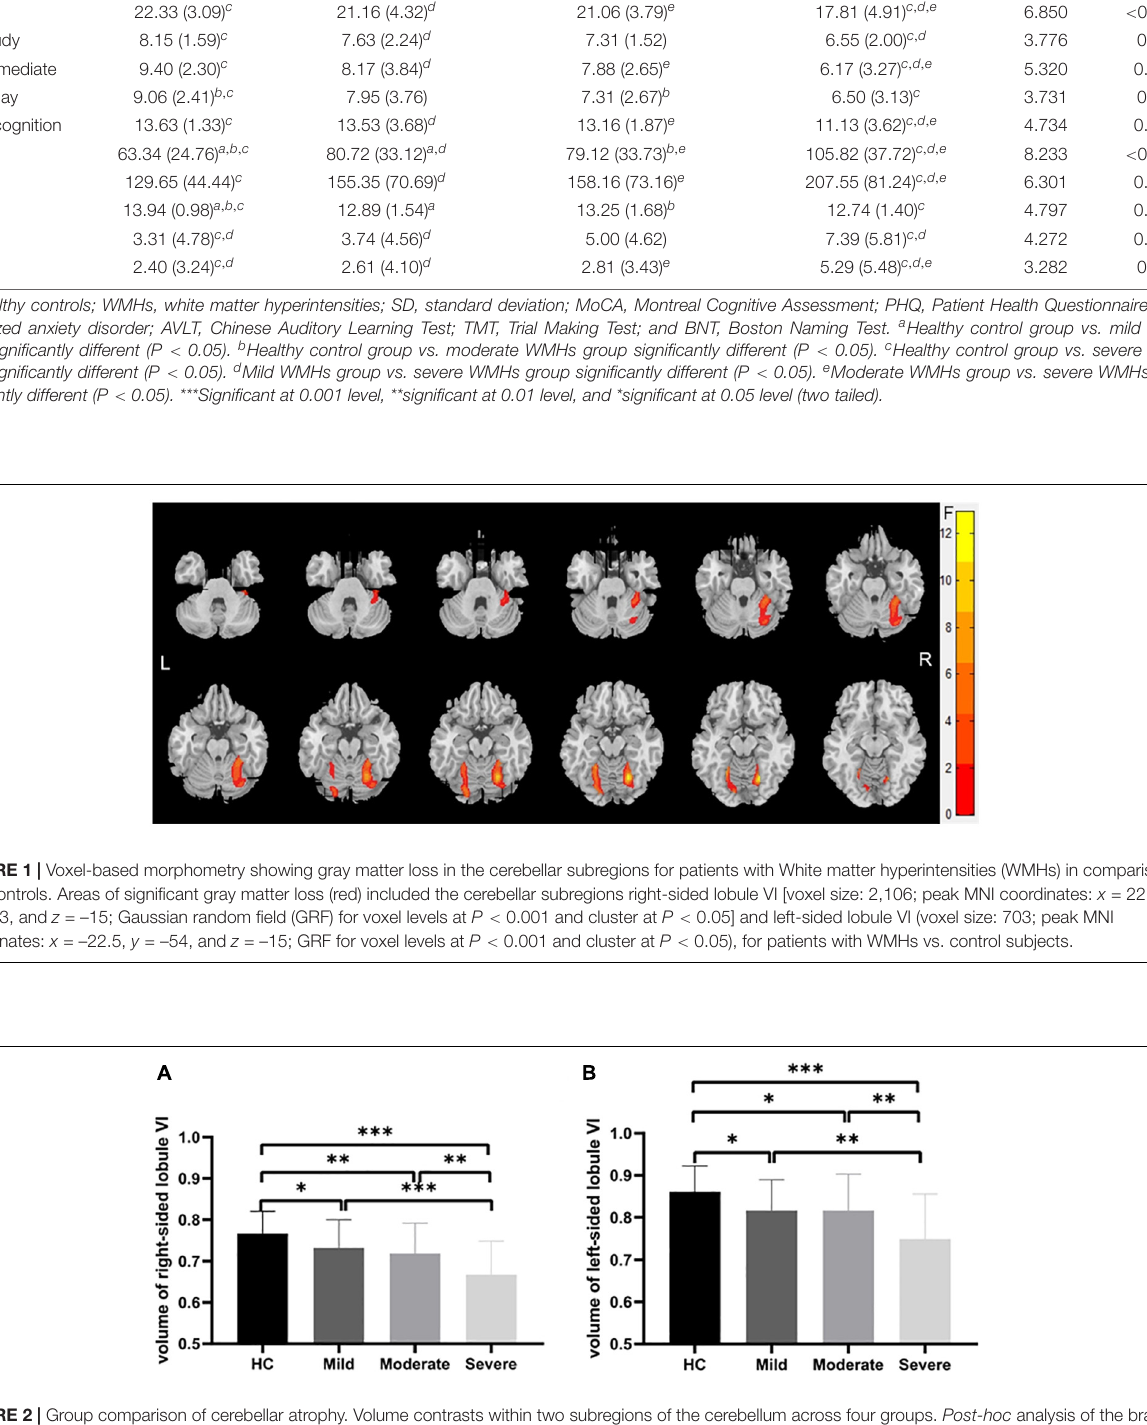
Frontiers in Aging Neuroscience |